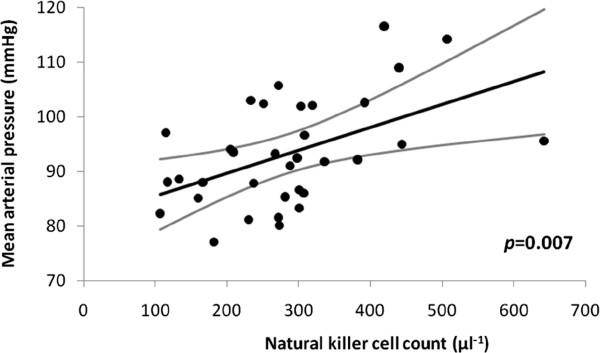
Relationship of supine mean arterial pressure to natural-killer count in core group, after adjustment for demographic covariates (standardised to age 65 years, time since diagnosis 6 years, body weight 80 kg). Regression line and 95% CI are shown. On inclusion of flexor-rigidity in multivariable model, cellular association remained 3.4 (0.4, 6.5) mmHg per 100 cells.μl-1 increment, p=0.03), and an additional small effect on pressure was seen (increase of 3.4 (0.8, 6.0) mmHg per 500 Nm.10-3 greater rigidity, p=0.01).